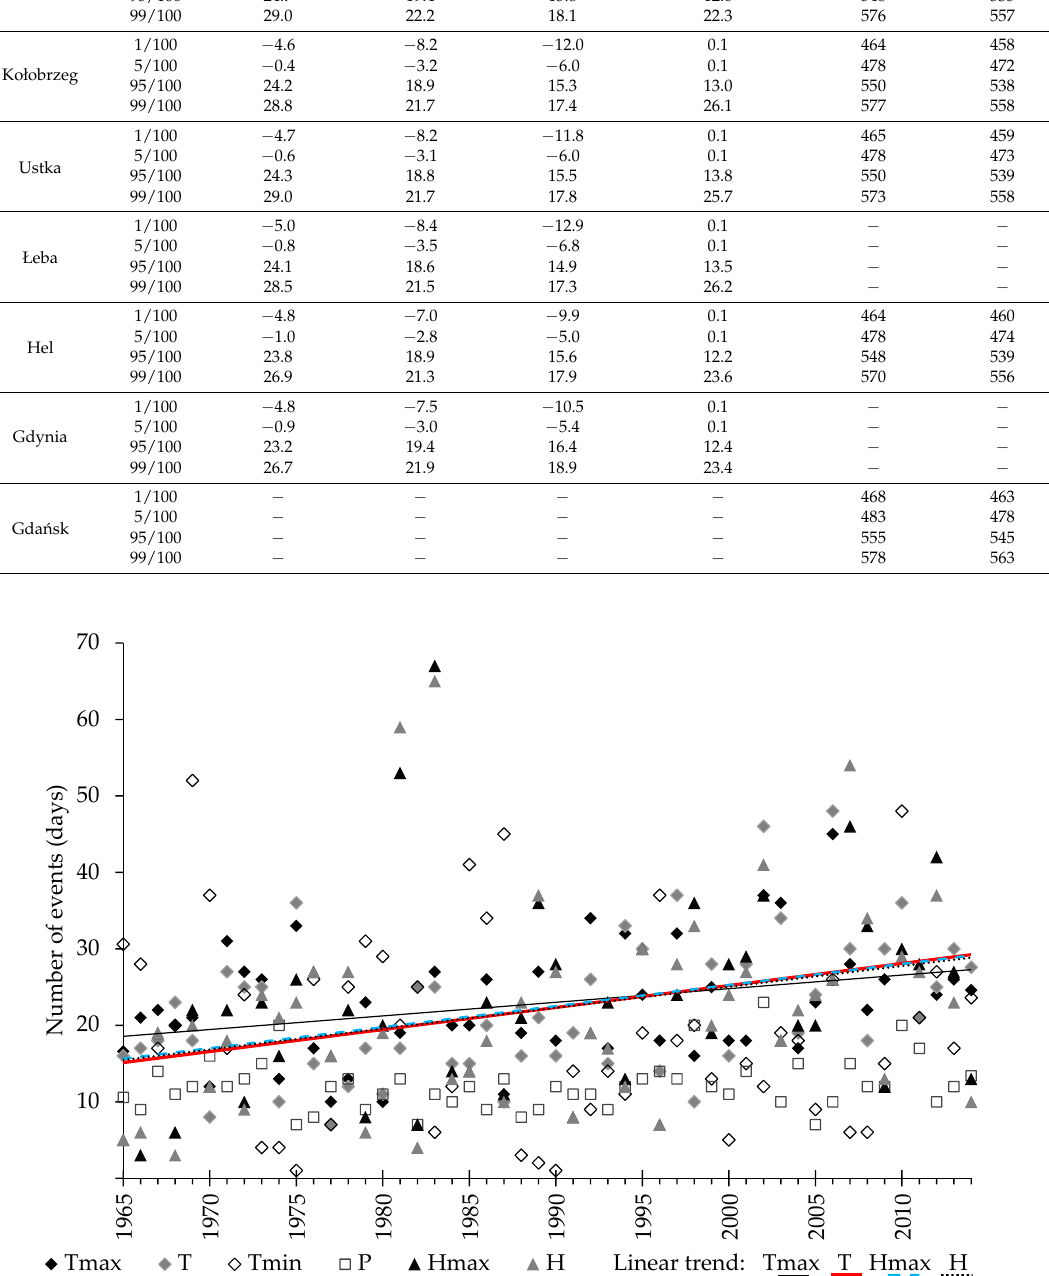
Table 4. Extreme threshold values (percentiles 5/100 and 95/100) and exceptionally extreme threshold values (percentiles 1/100 and 99/100) of hydrometeorological events in the Polish coastal zone of the South Baltic (1965–2014).